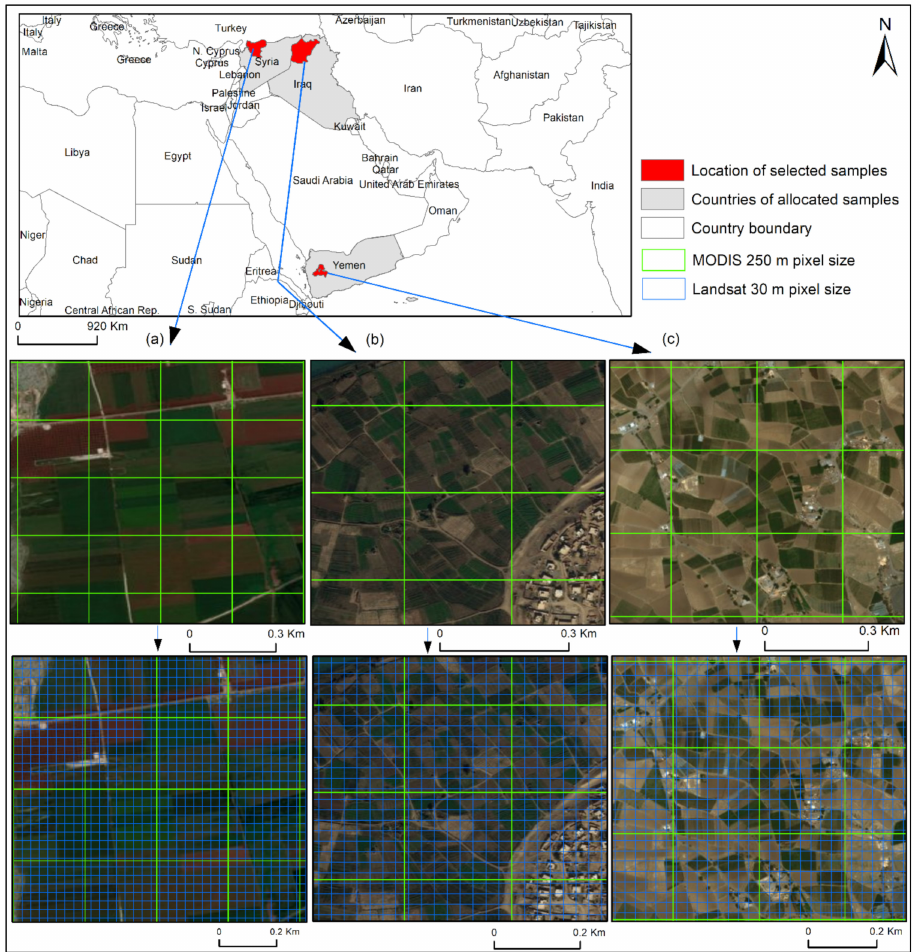
Figure 3. Three fine spatial resolution ArcGIS basemap images (<1 m) of agricultural areas selected from the Middle East to illustrate the agricultural detail that is lost within MODIS and Landsat images. Grid outlines representing 250 m pixels from MODIS and 30 m pixels from Landsat are shown overlaid on the base images. ( a ) North-East Aleppo, Syria, ( b ) South-East Mosul, Iraq and ( c ) South Sanaa, Yemen. (Service layer credits: Esri, DigitalGlobe, GeoEye, Earthstar, Geographics, CNES/Airbus DS, USDA, USGS, AiroGRID, IGN, and the GIS User